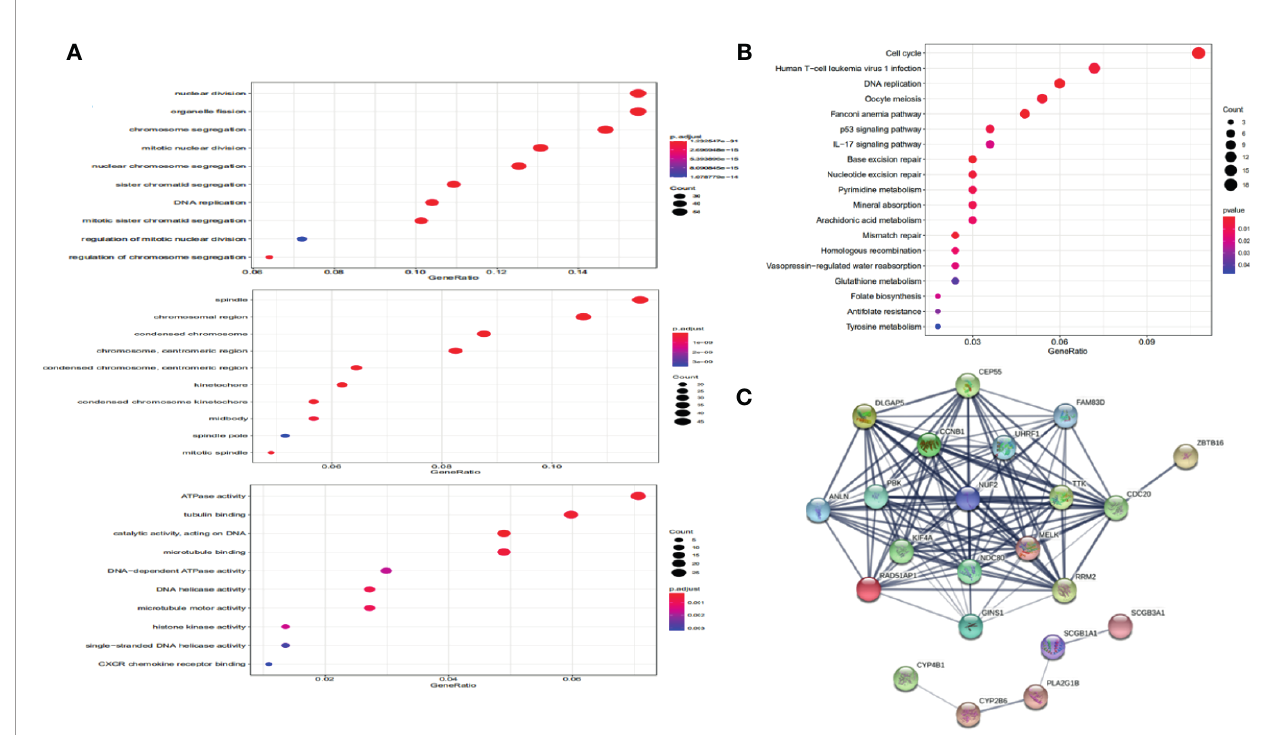
FIGURE 4 | Functional annotation and protein-protein interaction. (A) Signi fi cantly enriched GO annotations of NUF2 in NSCLC. (B) Signi fi cantly enriched KEGG pathways of NUF2 in NSCLC. (C) The PPI network of NUF2 from